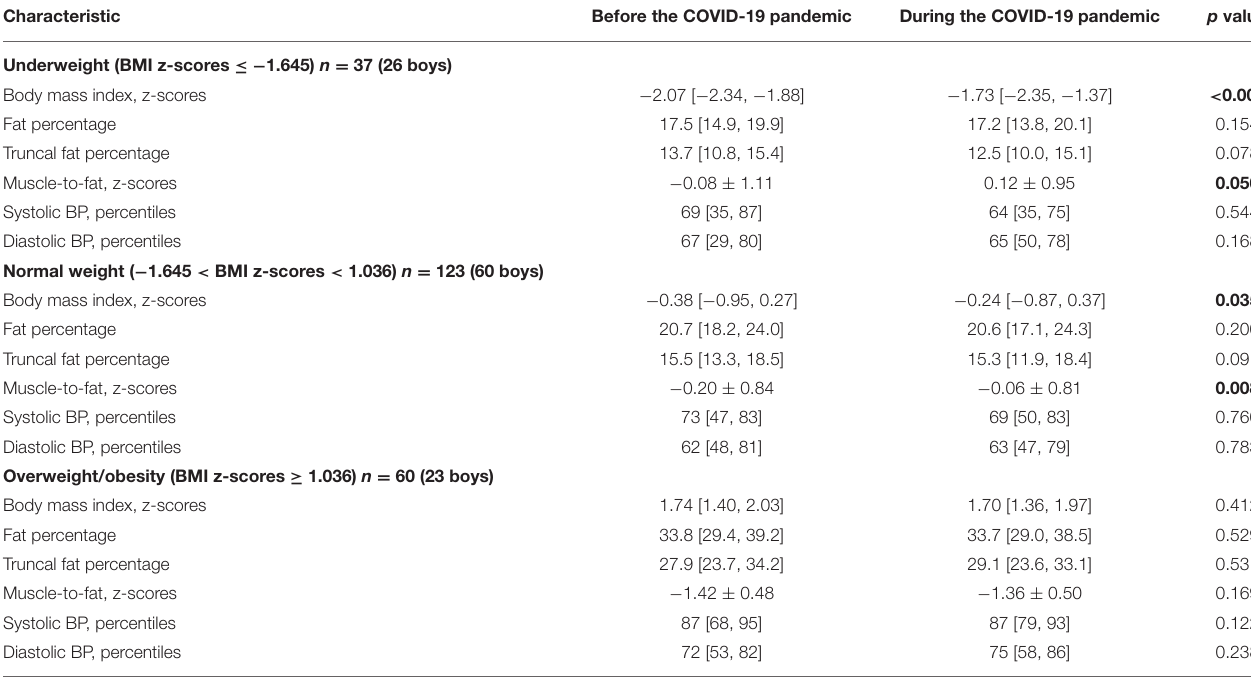
TABLE 2 | Body composition and blood pressure characteristics of 220 children and adolescents before and during the COVID-19 pandemic stratified according to weight status. Characteristic Before the COVID-19 pandemic During the COVID-19 pandemic p